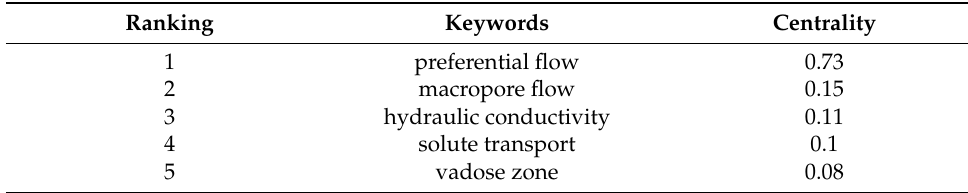
Table 2. Betweenness centrality of keywords from WoS database. Ranking